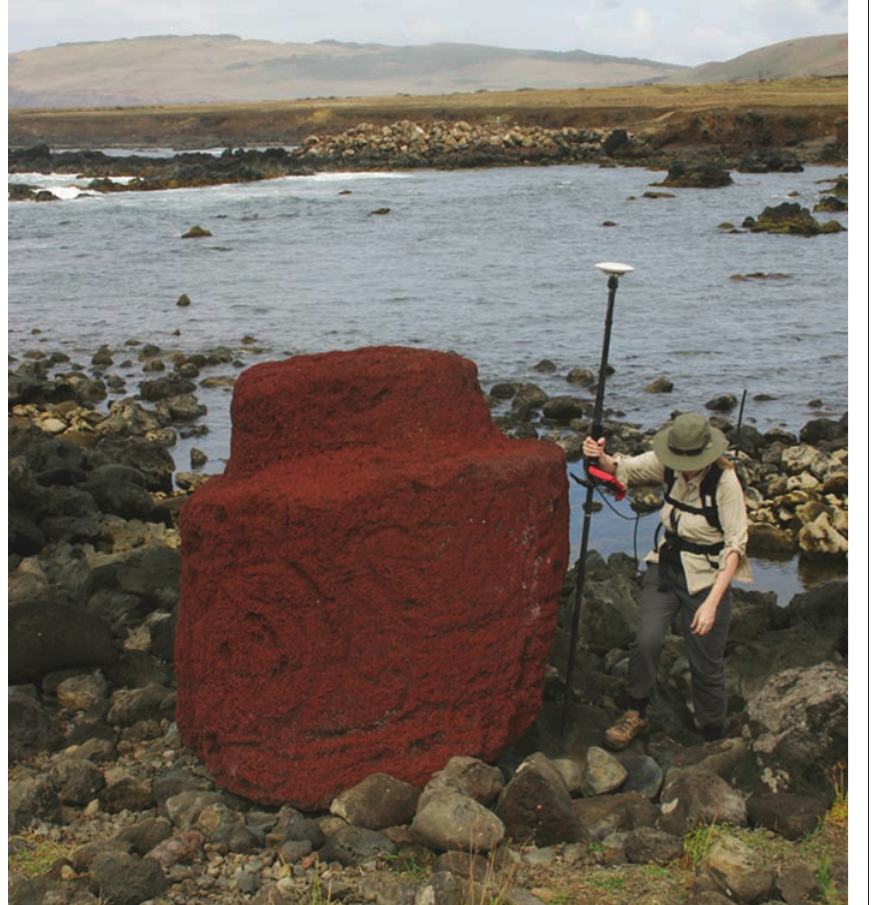
Figure 4 Kate Welham surveying the location of a toppled statue hat (pukao) at Ahu Hanga Tee